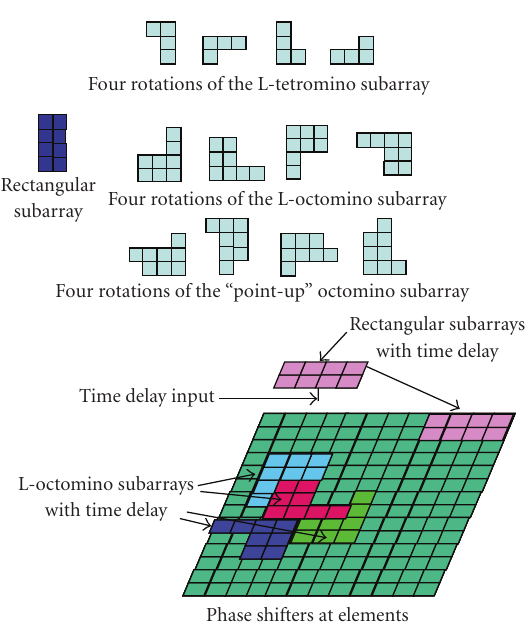
Figure 2: Irregular and rectangular